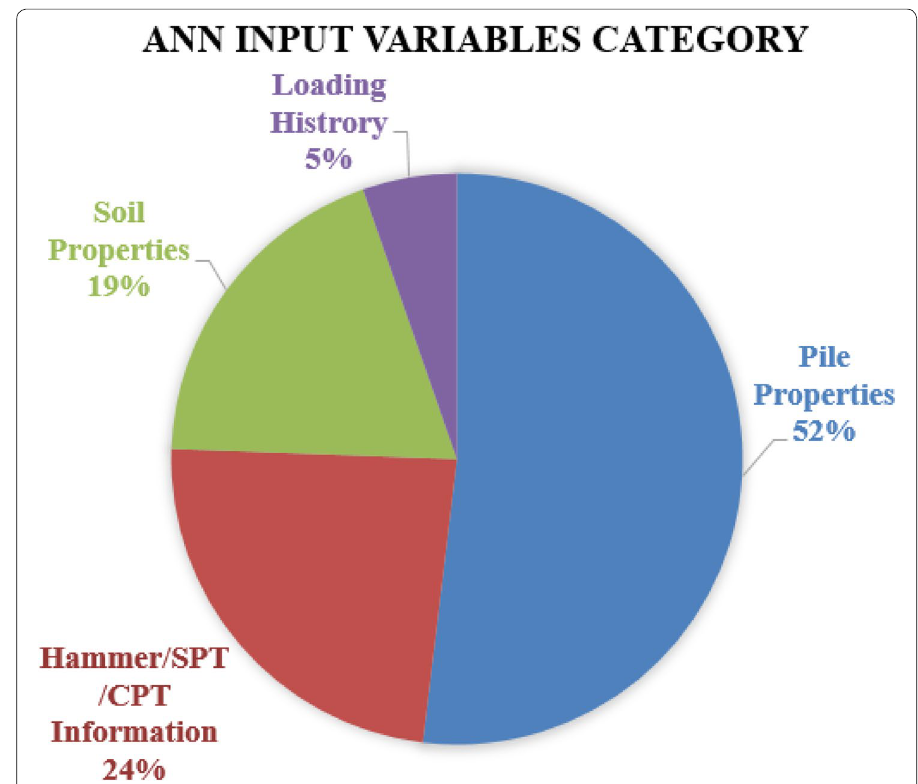
Fig. 4 Percentage of repeat for different categories of ANN input